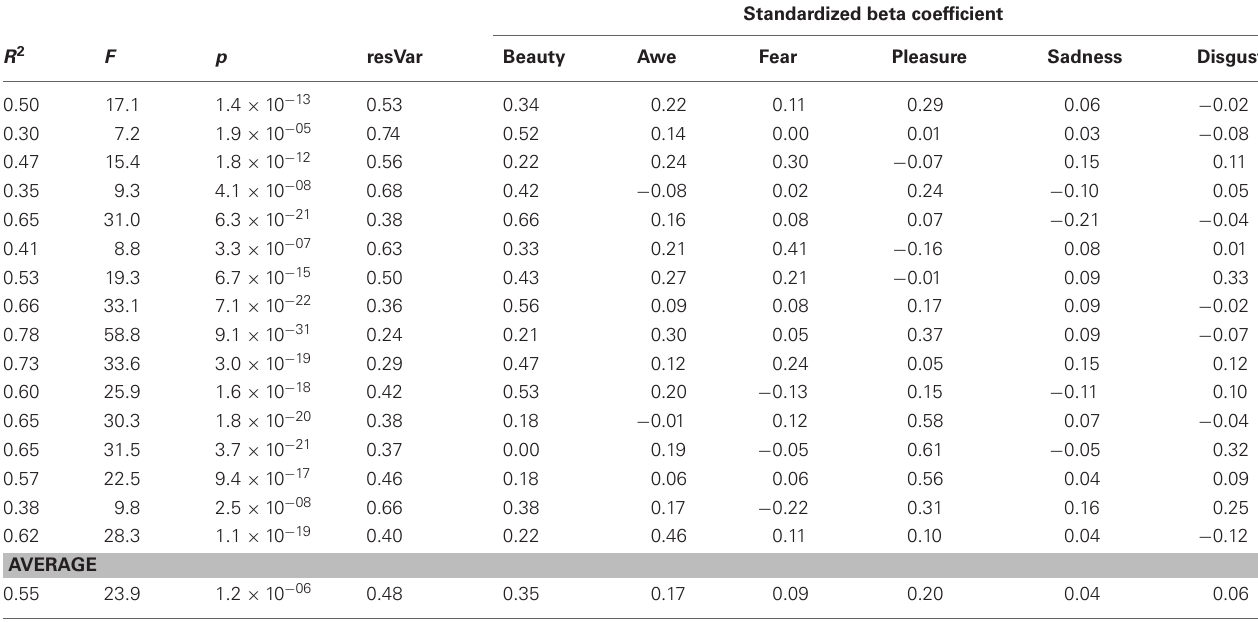
Table A2 | Results of the individual differences regression in which each observer’s recommendations were predicted from the reduced set of six emotional terms.